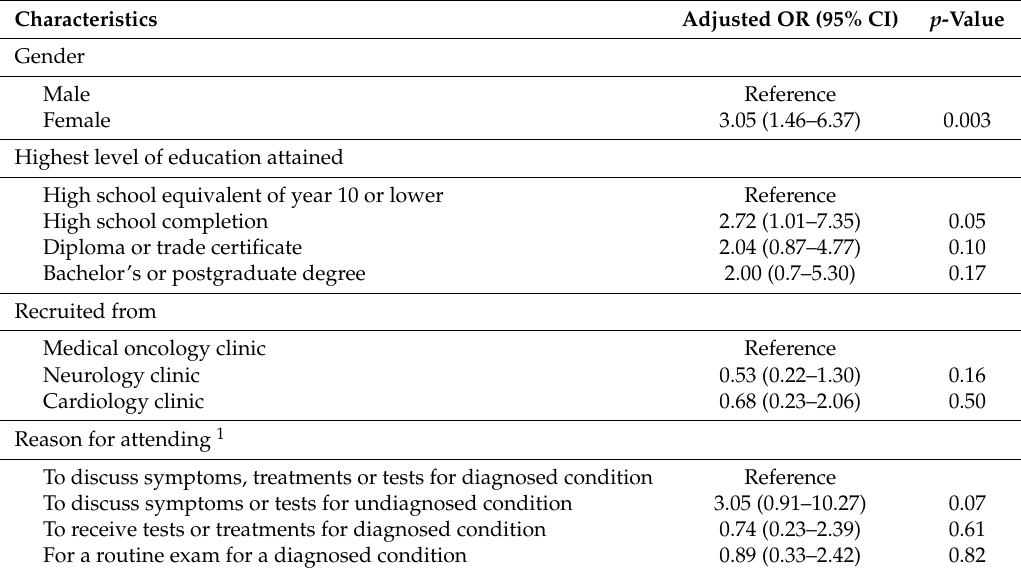
Table 4. Adjusted odds of selecting “Ensure concerns are discussed with health